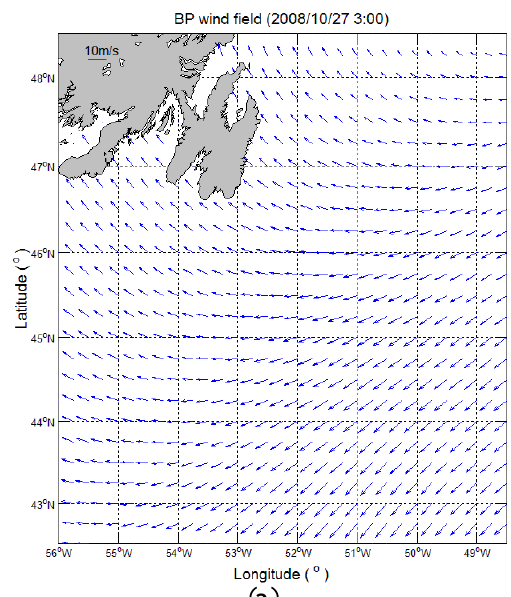
Figure 4. ( a ) BP wind field at 03:00, 20 October 2008. ( b ) Reconstructed wind field at 03:00, 20 October 2008. ( c ) BP wind field at 03:00, 24 October 2008. ( d ) Reconstructed wind field at 03:00, 24 October 2008. ( e ) BP wind field at 03:00, 27 October 2008 . ( f ) Reconstructed wind field at 03:00, 27 October